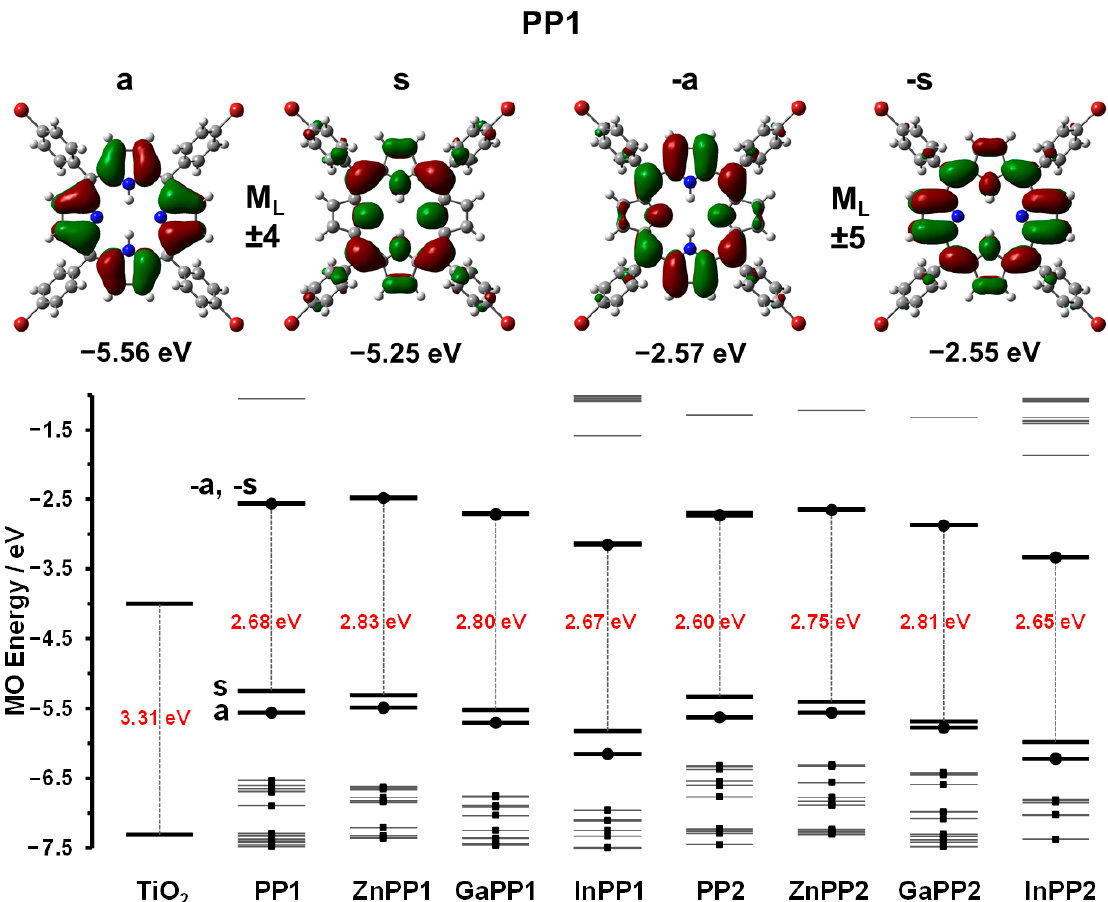
Figure 3. Angular nodal patterns and energies of the a , s , − a and − s MOs of PP1 (TOP). Calculated MO energies and HOMO − LUMO gaps for TiO 2 [31], PP1 , PP2 and the metal porphyrin complexes from the B3LYP geometry optimizations (BOTTOM). The a , s , − a and − s MOs are highlighted with thicker black lines, while other occupied MOs are denoted with a small black square. Black circles are used to highlight the a and − a MOs. The HOMO − LUMO gaps are denoted with vertical black dashed lines and the values are provided in red text.